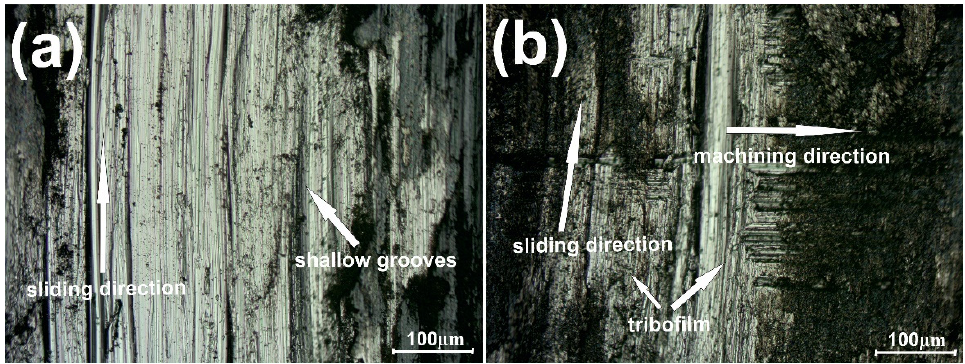
Figure 7. Surface condition of the counter-specimen mating with Ni-50%NiCr(80/20) ( a ) and Ni-